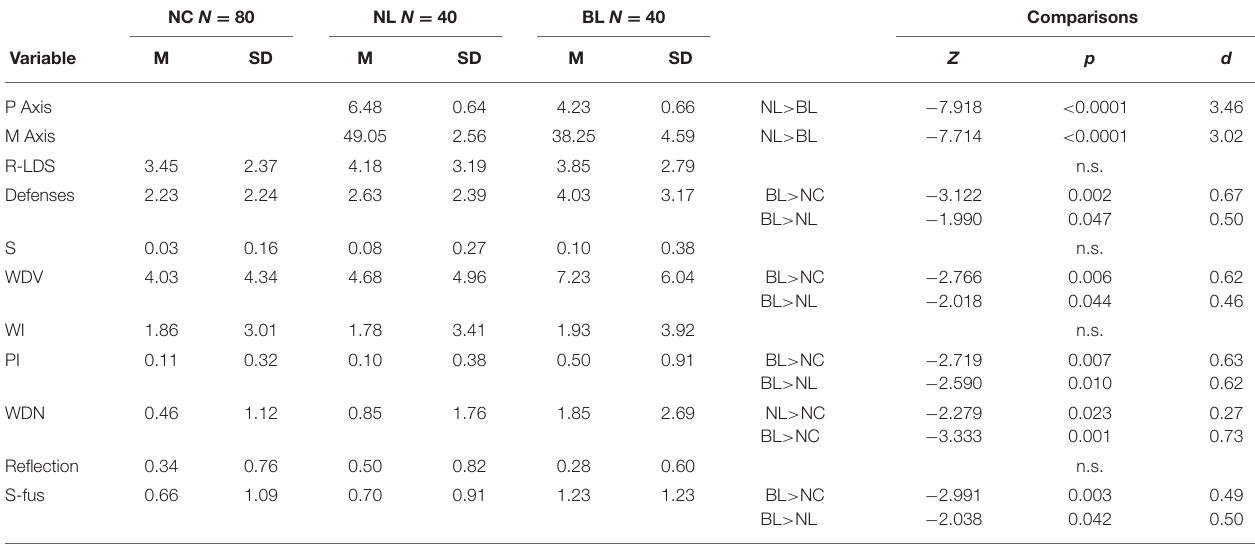
TABLE 2 | Descriptive statistics and comparisons between non-clinical and clinical groups.